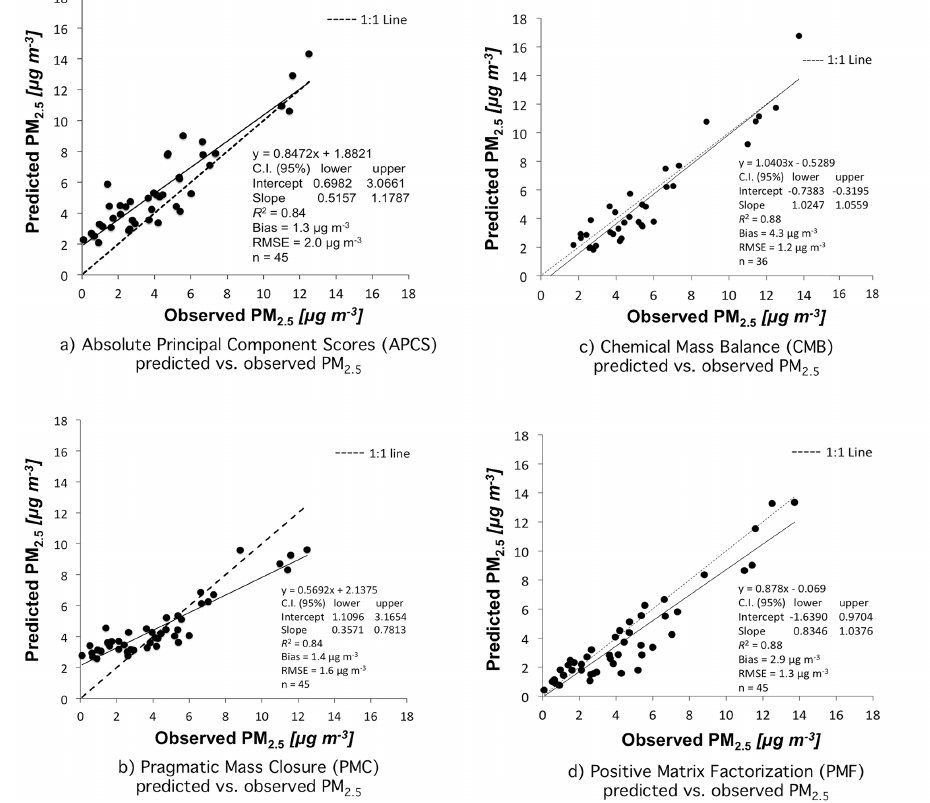
Figure 1. Parity plots of observed vs. predicted PM 2 . 5 estimated by the four receptor models: (a) absolute principal component scores (APCS), (b) pragmatic mass closure (PMC), (c) chemical mass balance (CMB) and (d) positive matrix factorization